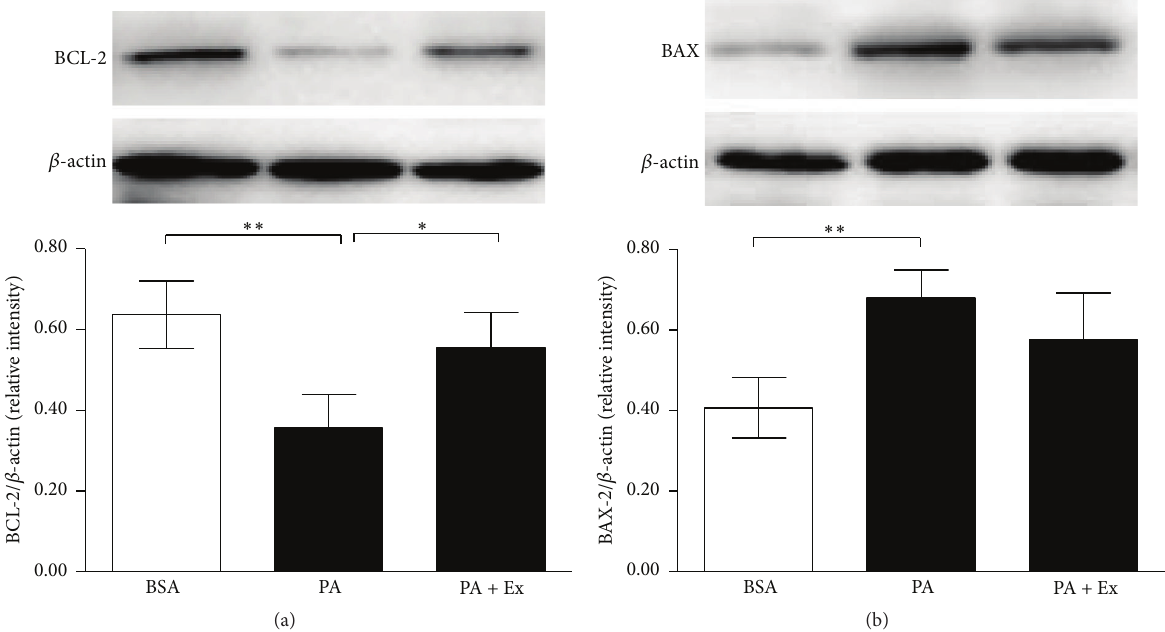
Figure 3: The antiapoptotic effect of exendin-4 involves the mitochondrial apoptosis pathway. MIN6 cells were incubated in serum-free DMEM with 0.5% BSA (BSA) or 0.4 mM palmitate added 0.5% BSA (PA), with or without 100nM exendin-4 (Ex) for 24 h. Protein expression of BCL-2 (a) and BAX (b) was assessed by western blot in MIN6 cells. Values are expressed as relative intensity ratio of BCL-2 or BAX to 𝛽 -actin and represent the mean ± SE of three independent experiments. ∗ 𝑝 < 0.05 , ∗∗ 𝑝 < 0.01